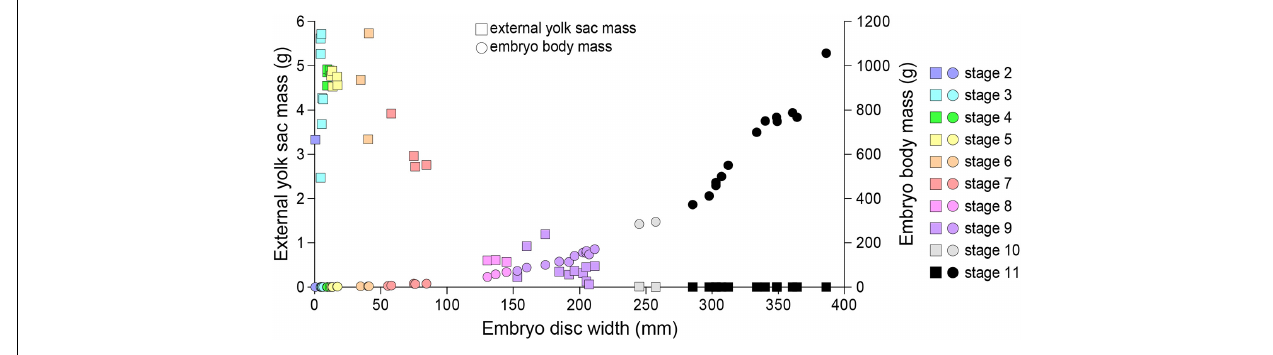
FIGURE 10 | The relationship between the embryo disc width, embryo body mass and the external yolk sac mass for Aetobatus narutobiei .